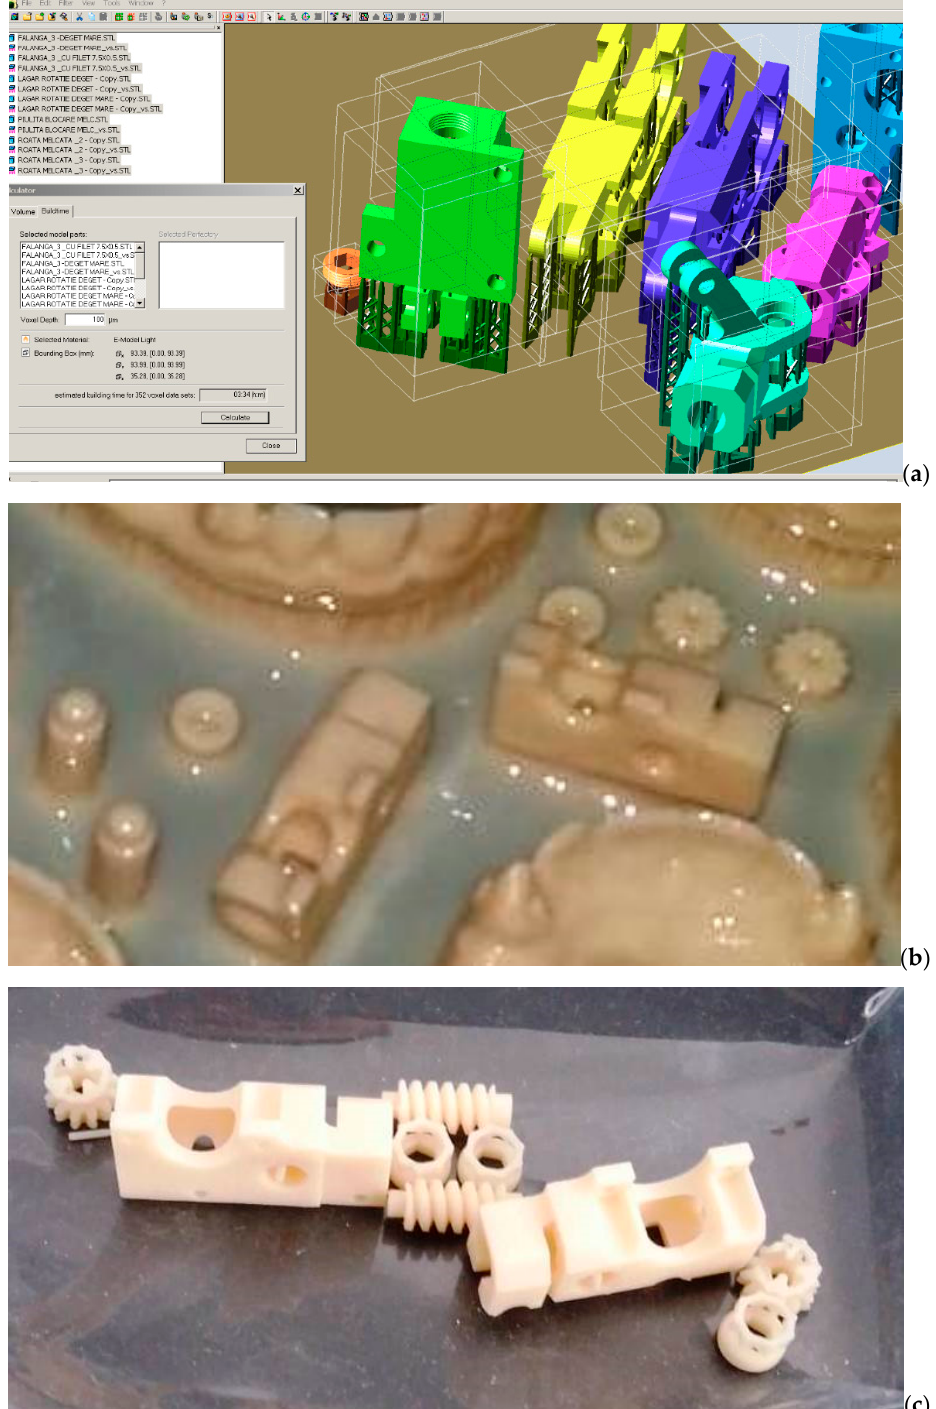
Figure 18. 3SP printing of mechanical parts. ( a ) Model construction and position, ( b ) models at the final printing process, ( c ) printed parts.